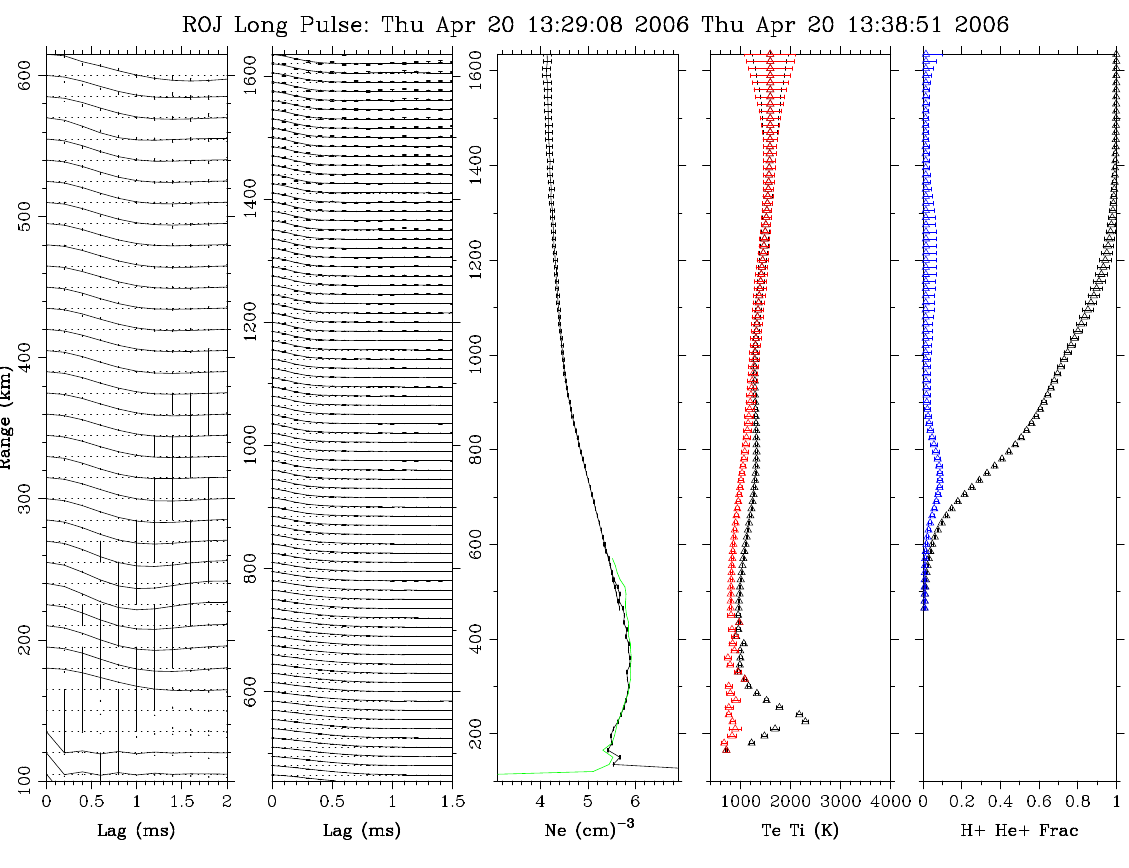
Fig. 6. Jicamarca profiles for 13:30 LT (18:30